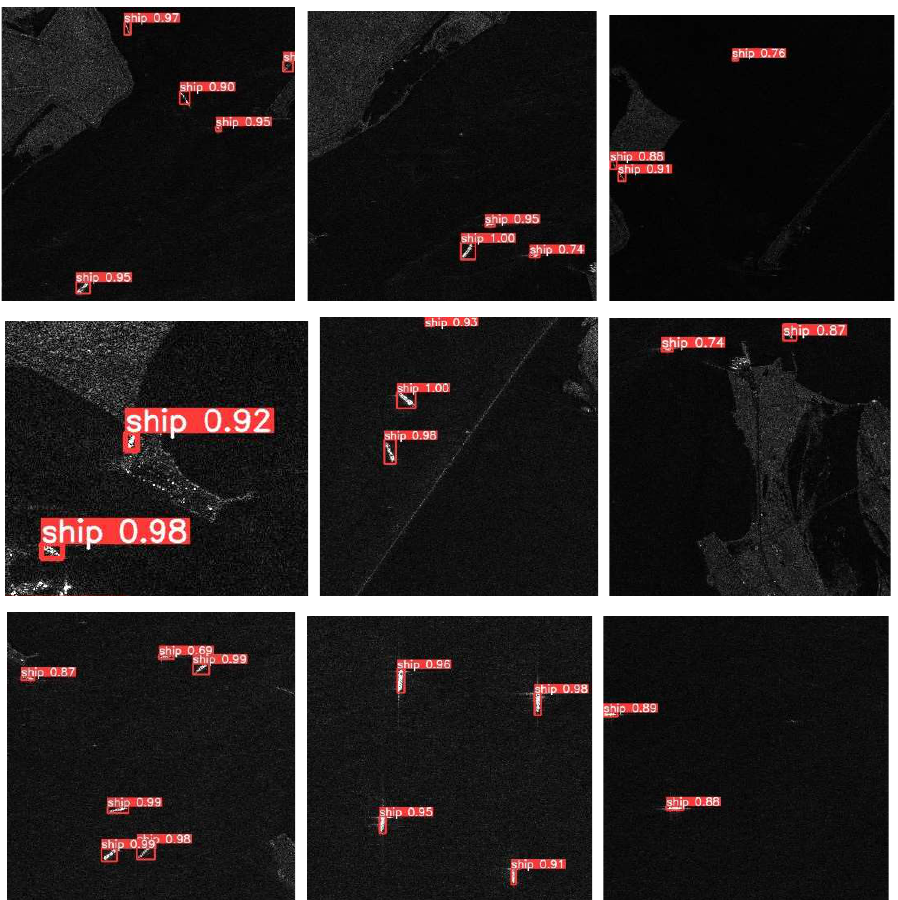
Figure 13. Visualization effect of our experiment on the HRSID dataset under the SSDD dataset training.